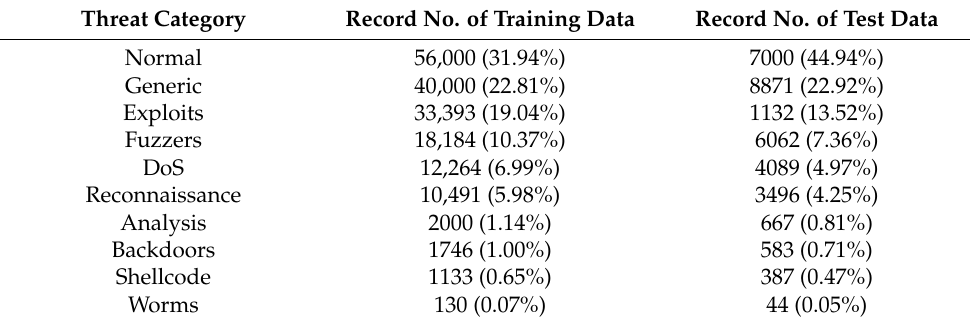
Table 2. Number of data points for each threat category